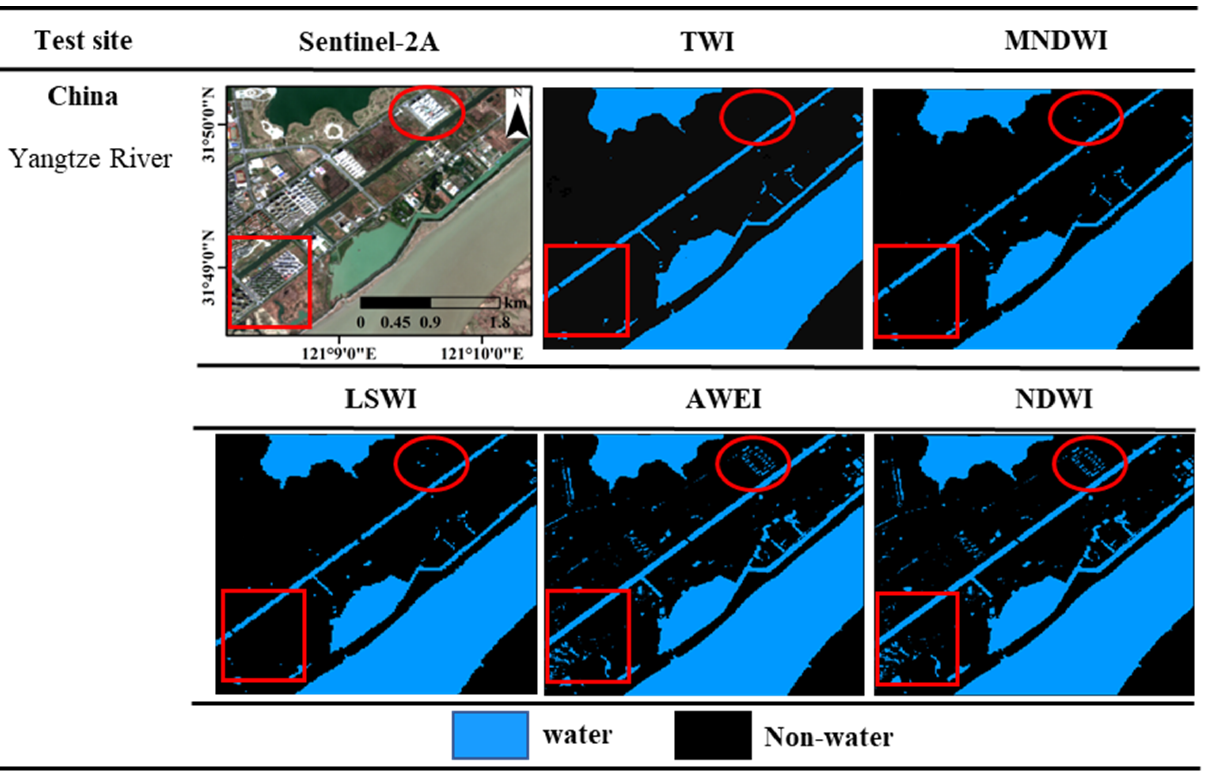
Figure 11. Comparative display of water extraction results based on five different methods. Senti- nel-2A color composite bands 4, 3, 2 coded RGB. Red marked areas are regions of building shadows.